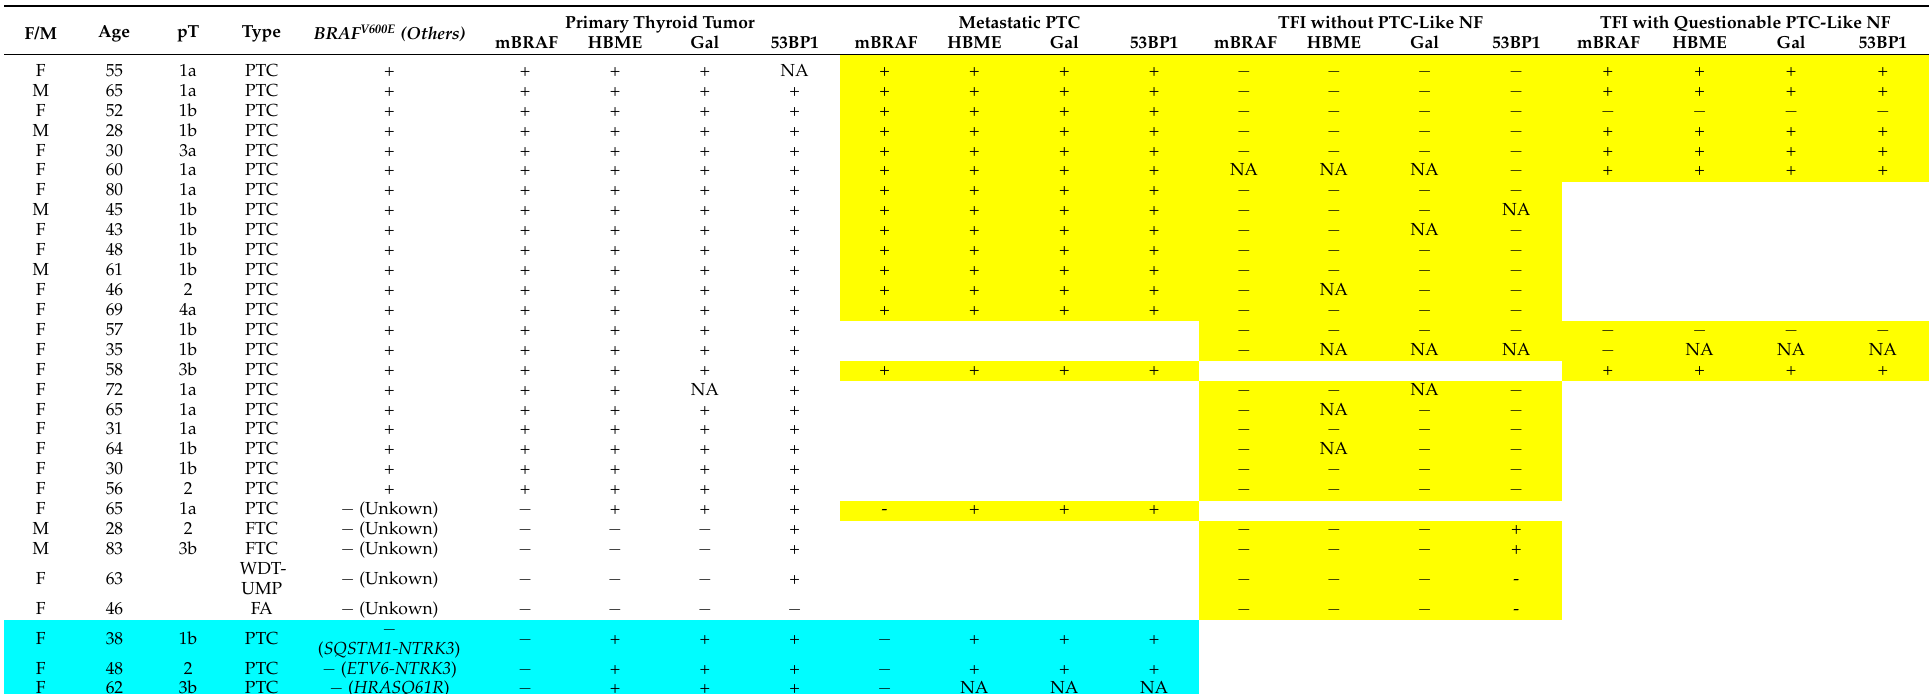
Table 1. Summary of clinicopathological profiles of the patients and results in this